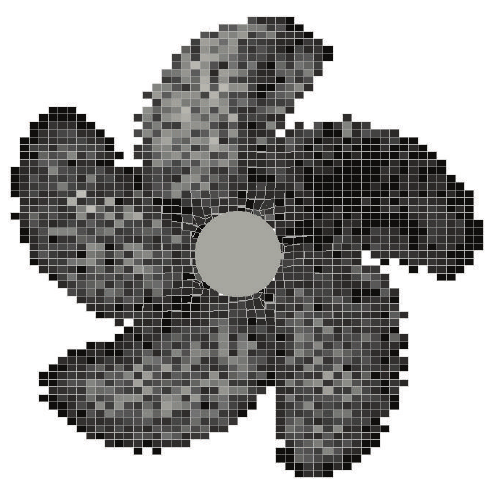
Figure 2: Illustration of RANS mesh cells containing propeller blade body forces (approximately 2500 cells are involved).